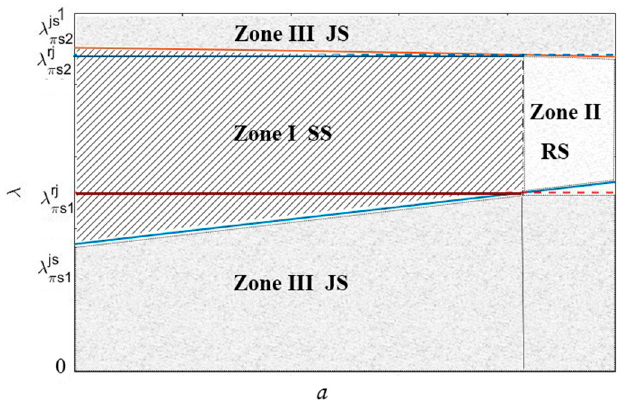
Figure 2. Pre-sale strategy selection preference of the supplier; SS, RS and JS represent supplier pre-sale strategy, retailer pre-sale strategy and joint pre-sale strategy, respectively.